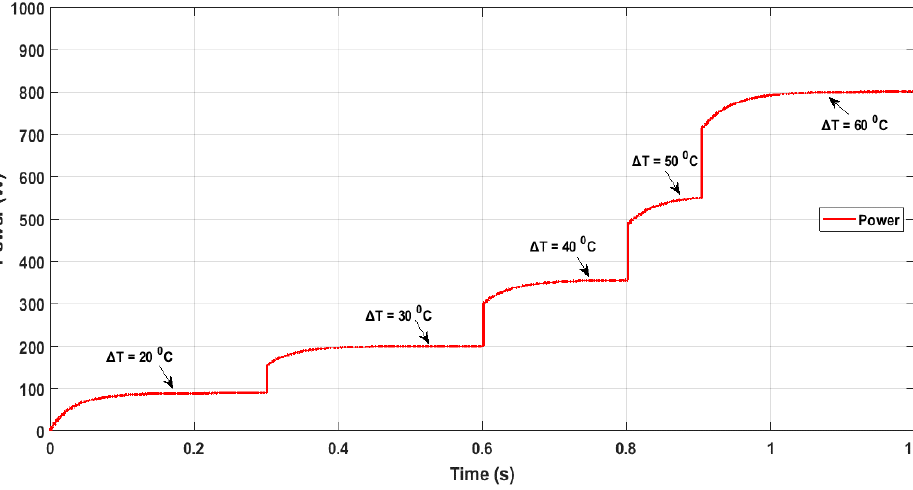
Figure 9. Power at various T h values when the IT2FLC technique is applied.